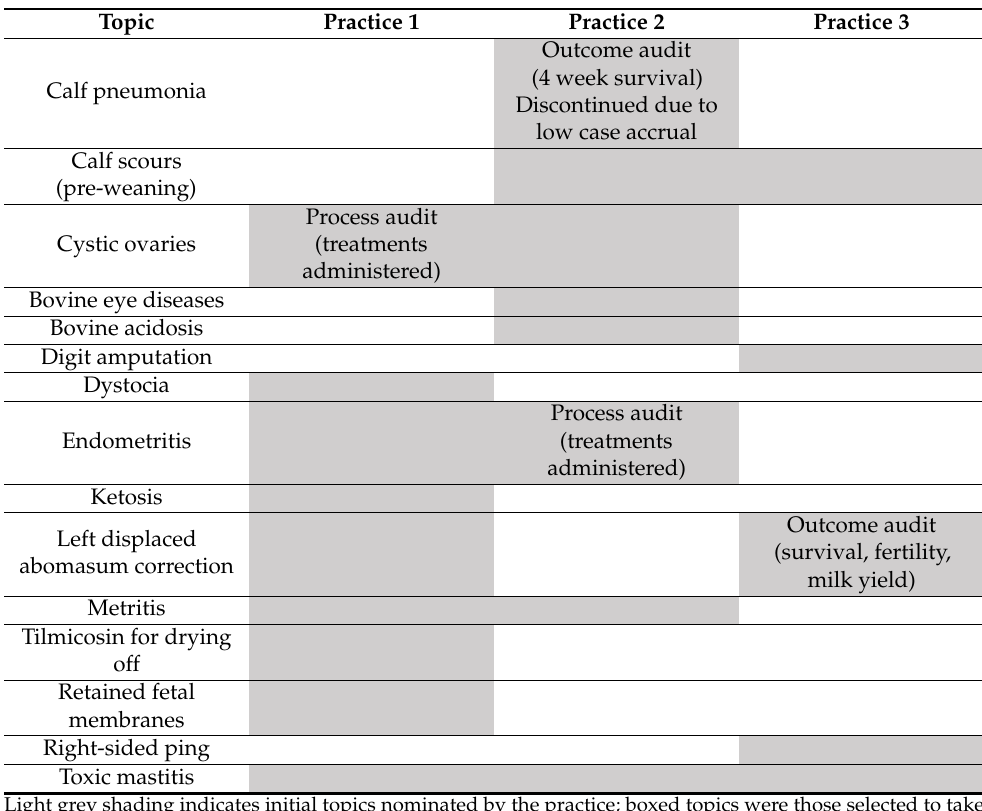
Table 1. Topics considered and selected for clinical audit in each practice.